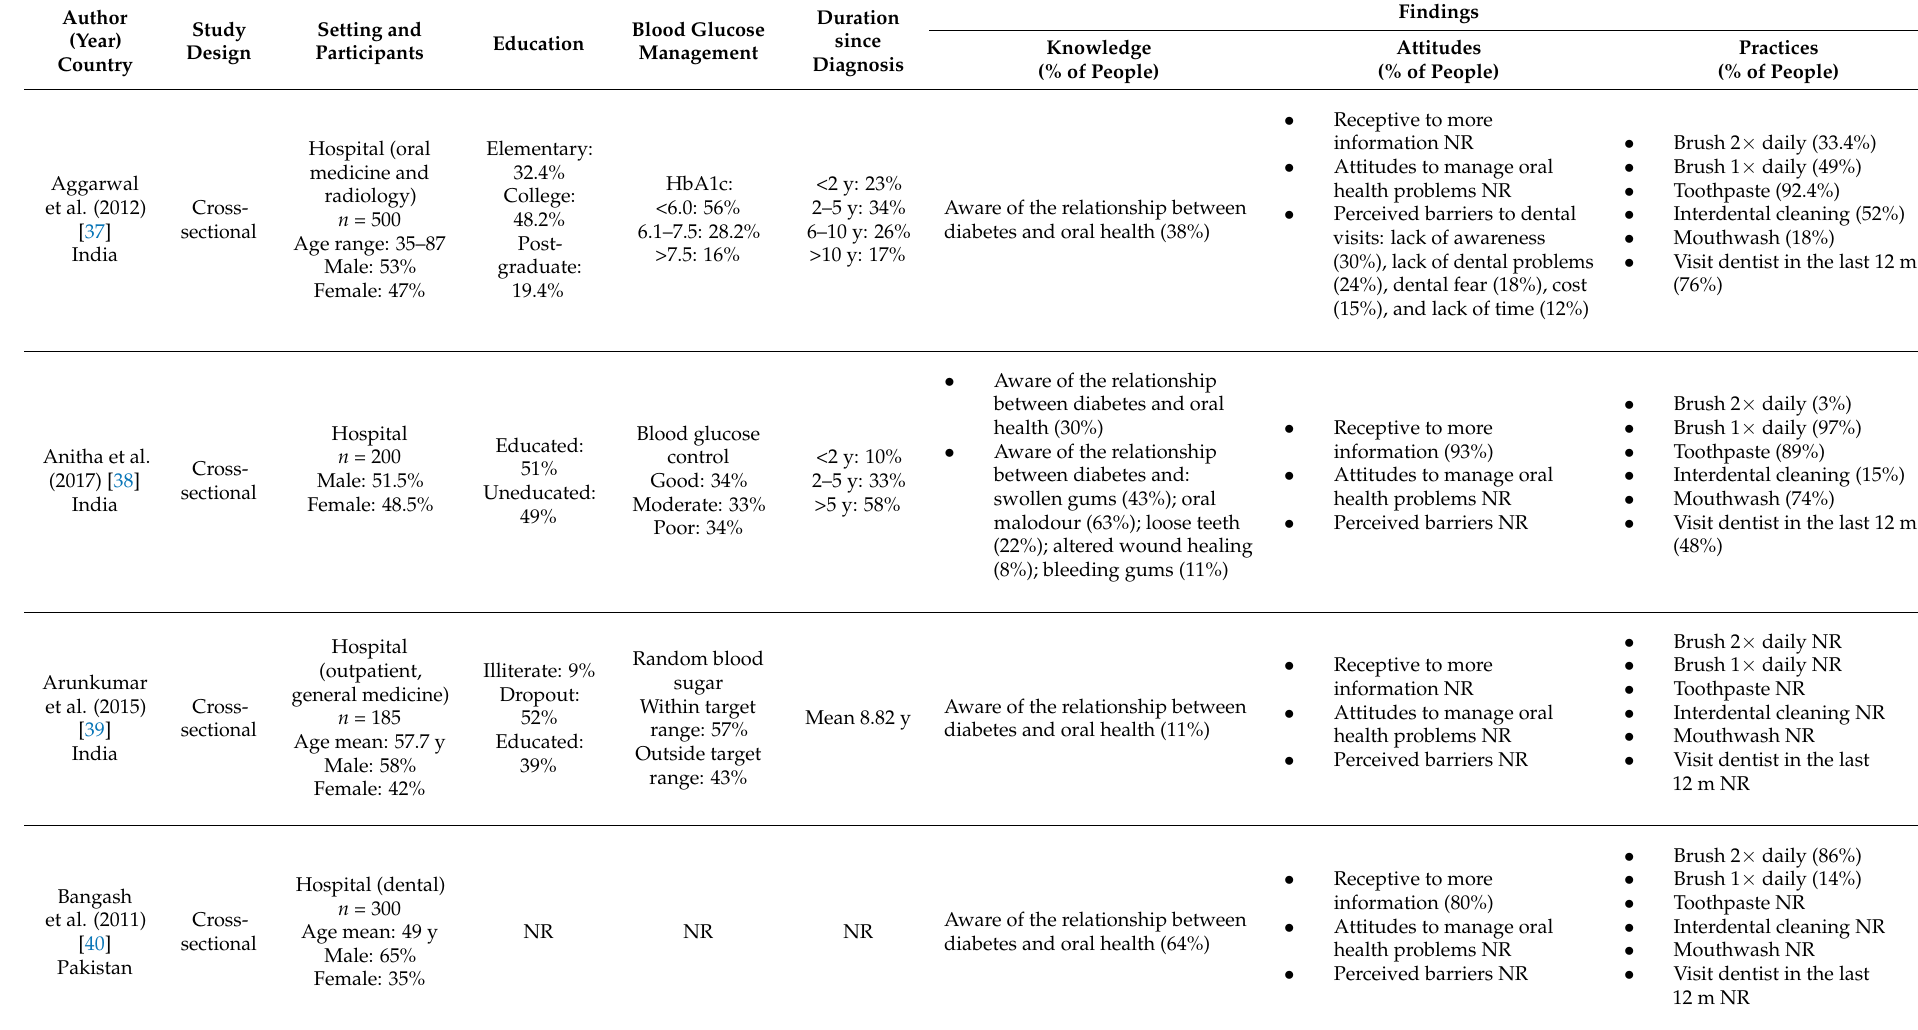
Table 1. Summary of the included studies with main